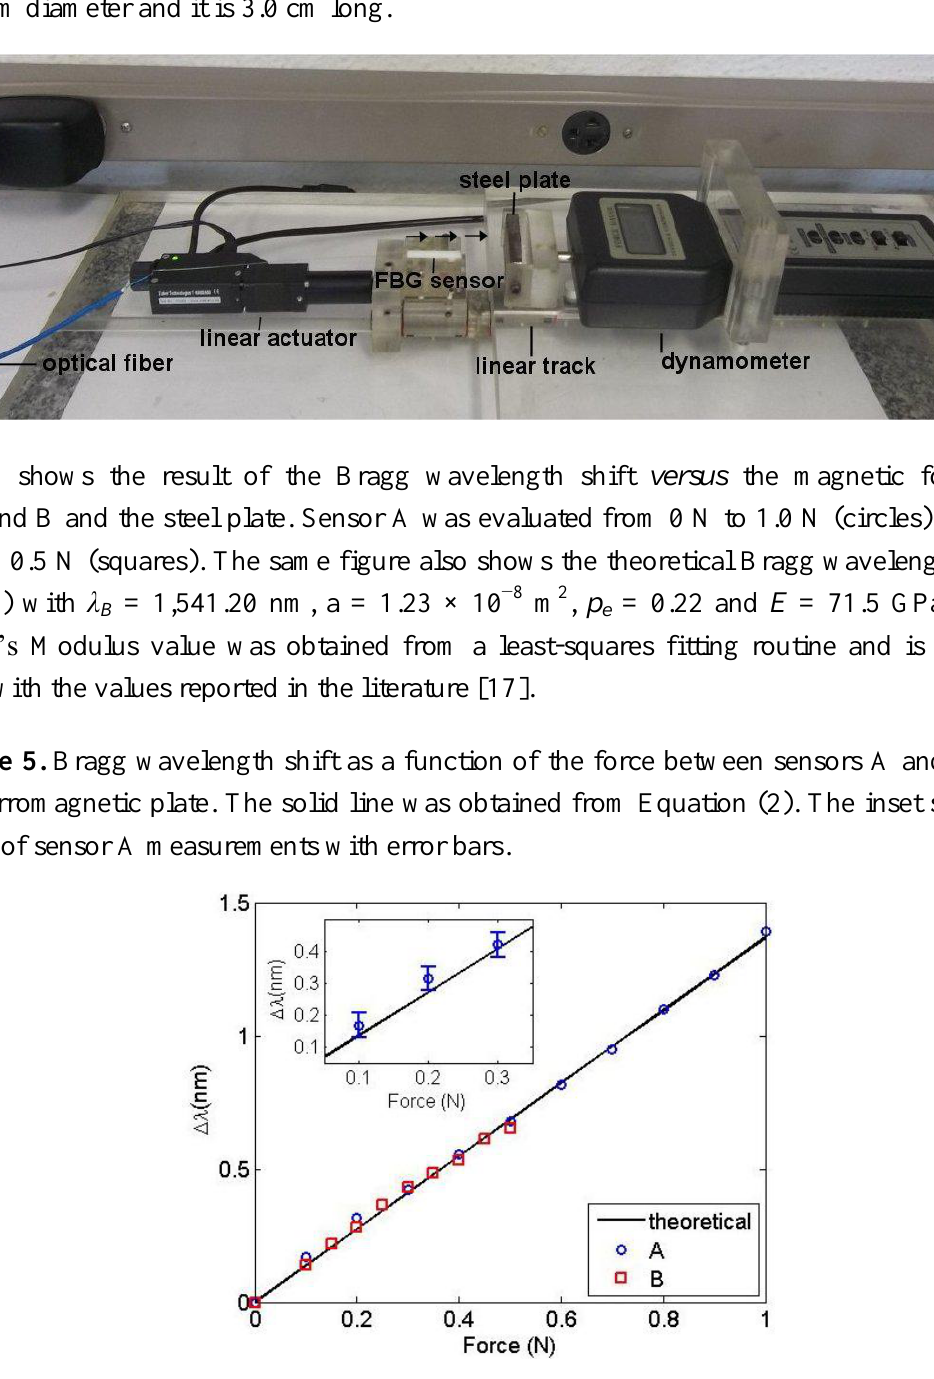
Figure 4. Photograph of the experimental setup for sensor calibration. The linear actuator displaces the FBG sensor towards the steel plate as shown by the arrows. The interrogation systems measure the wavelength change and the dynamometer measures the attractive force between the sensor magnet and the steel plate. The FBG sensor Teflon case has 6.0 mm diameter and it is 3.0 cm long.